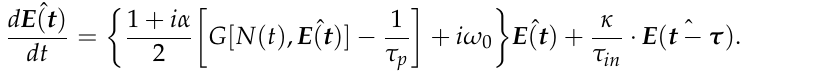
Figure 1. Basic structure of a laser with external optical feedback.